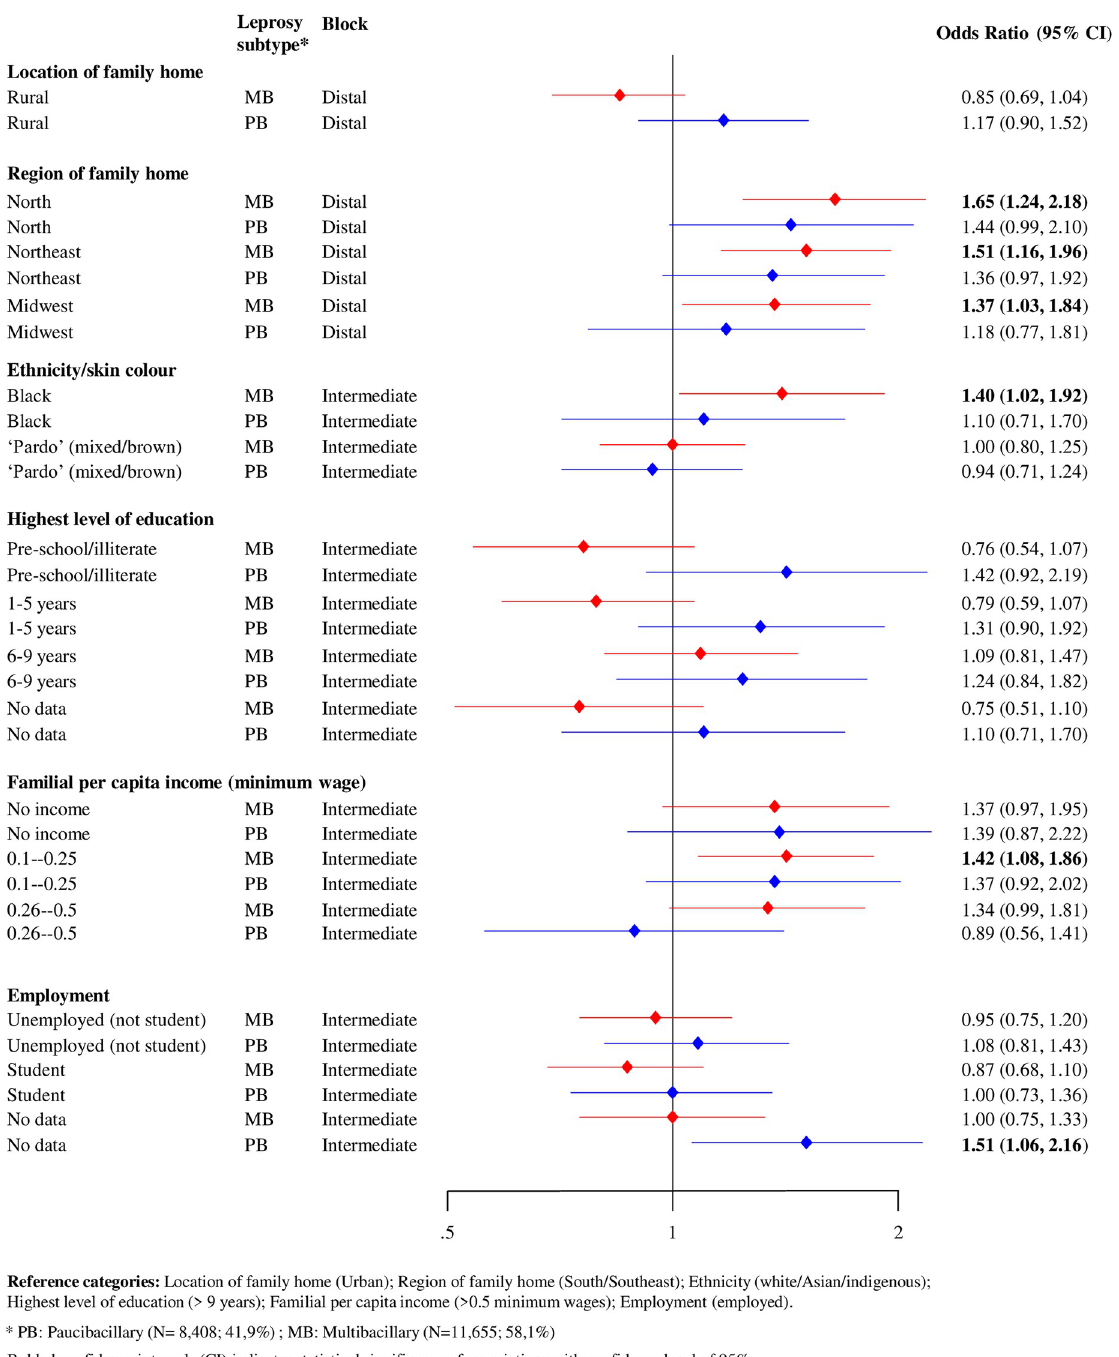
Fig 3. Forest plot of hierarchical association of distal and intermediate factors with leprosy treatment default (N = 20,063), stratified by leprosy subtype, Brazil, 2007–2014.